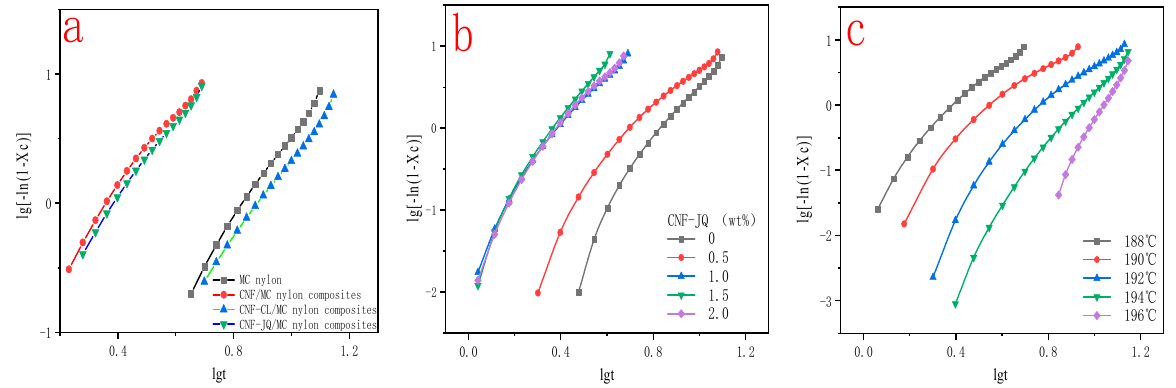
Figure 9. Avrami plots of MC nylon and MC nylon composites isothermally melt crystallized (( a ) is the curve of different modified CNF with a filling of 1.0 wt% at a cooling rate of 188 °C; ( b ) is the curve of different CNF − JQ additions at a cooling rate of 188 °C; ( c ) is the curve of different cooling rates for CNF − JQ of 1.0 wt%).